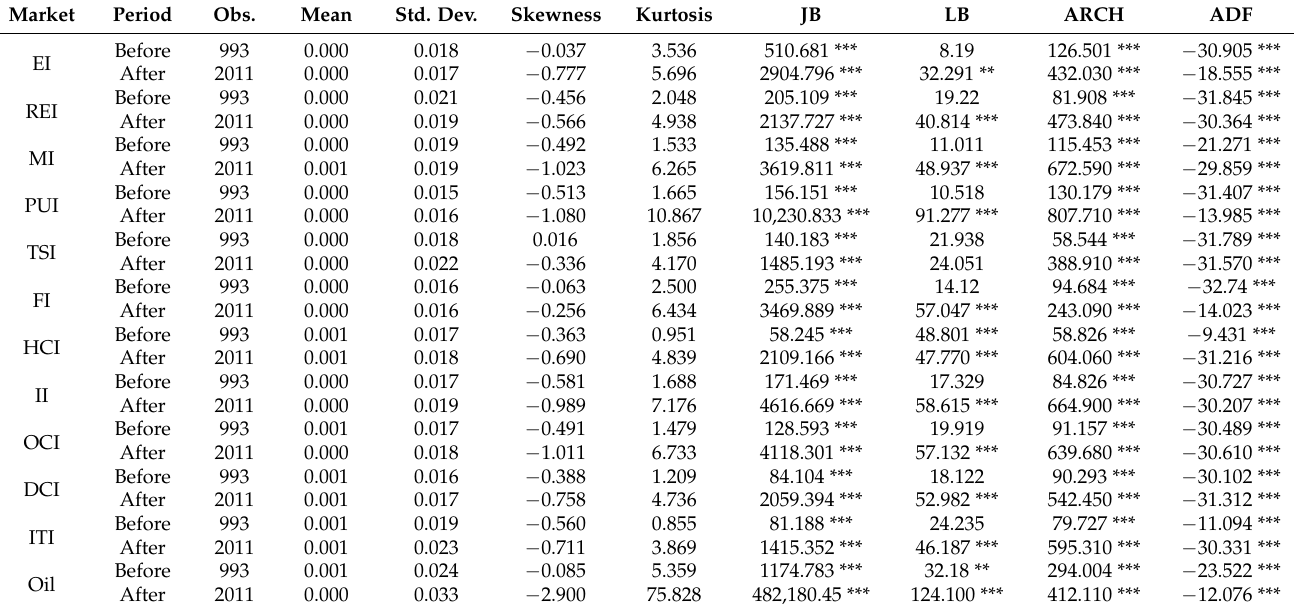
Table 1. Descriptive statistics of log-return